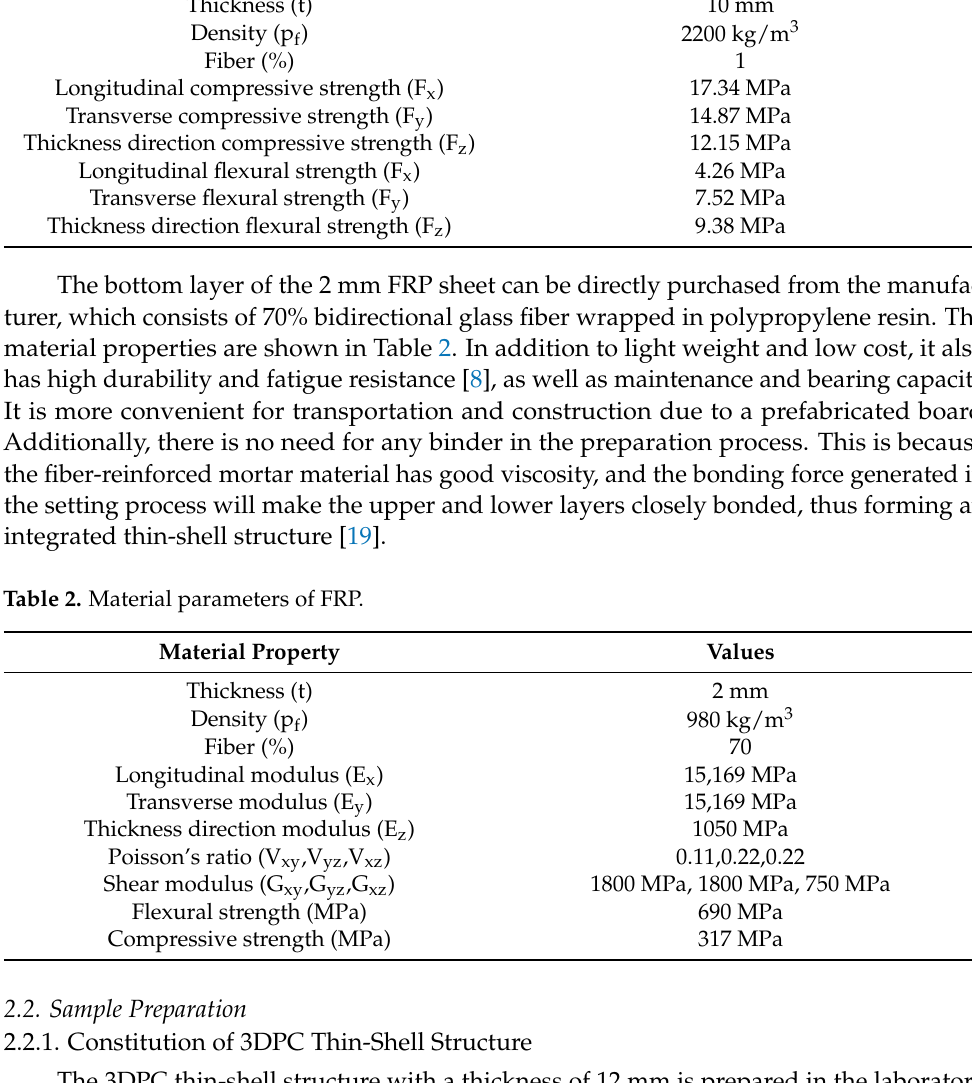
Table 1. Material parameters of fiber cement materials.